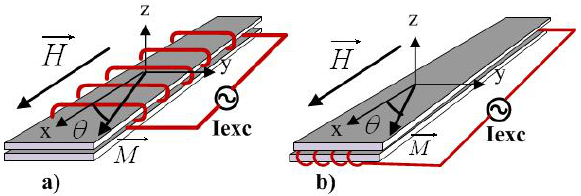
Figure 2. Transverse (a) and longitudinal (b) wire-wound ferro- magnetic ribbon constituting the magnetic sensor under the ambient magnetic field (H).